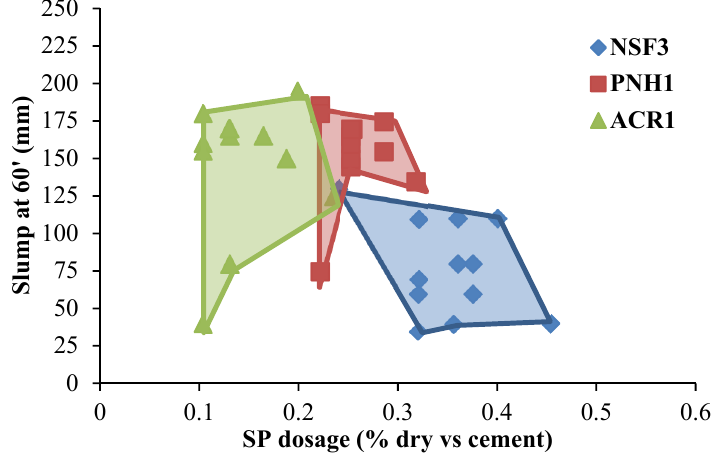
Figure 3. Slump value after 60 min as a function of the superplasticizer dosage.